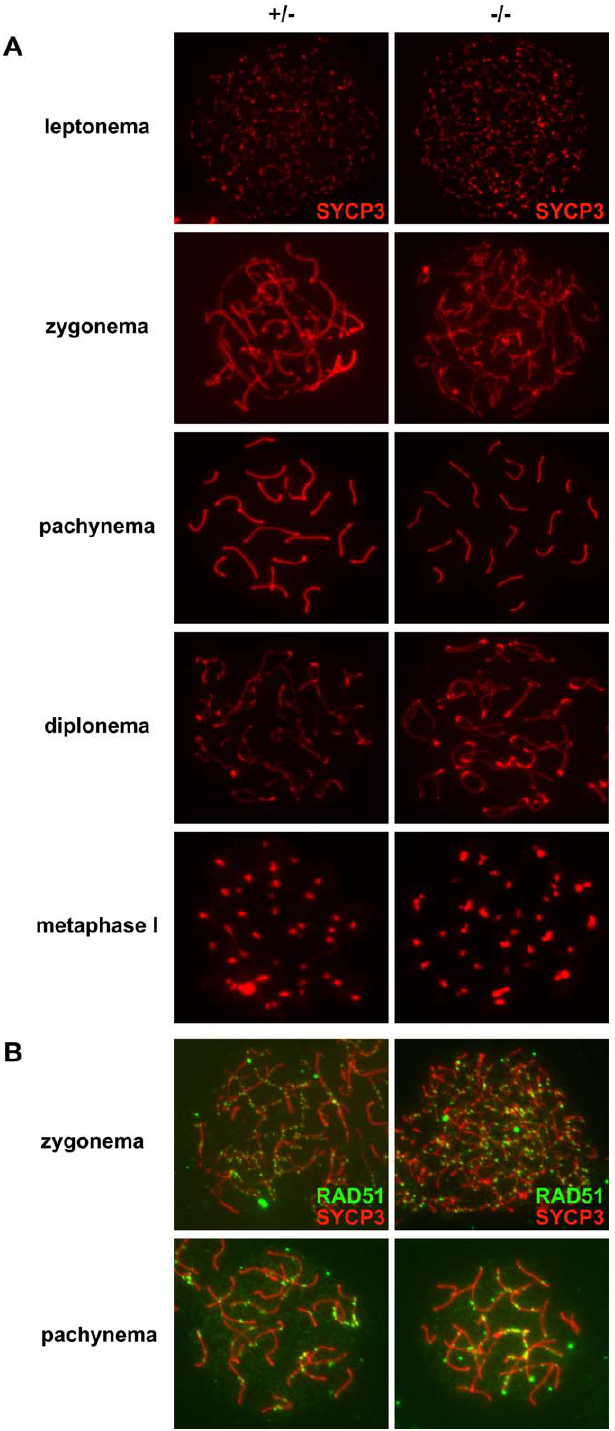
Figure 5. Normal Synapsis and Recombination in Dmrt7 Mutant Germ Cells (A) Testicular cells from Dmrt7 heterozygous ( þ / (cid:2) ) or homozygous ( (cid:2) / (cid:2) ) mutant mice were spread and stained with antibody to SYCP3 (red). The developmental stages of meiotic prophase based on SYCP3 organization are indicated in each panel. By pachynema, all autosomes are fully synapsed, and the XY bivalent is synapsed only at the pseudoautosomal region in both wild-type and mutant cells. (B) Testicular cells in zygonema and pachynema spread and stained with antibodies to RAD51 (green) and SYCP3 (red). Size and distribution of RAD51 foci are similar between wild-type and mutant spermatocytes. doi:10.1371/journal.pgen.0030062.g005 PLoS Genetics |